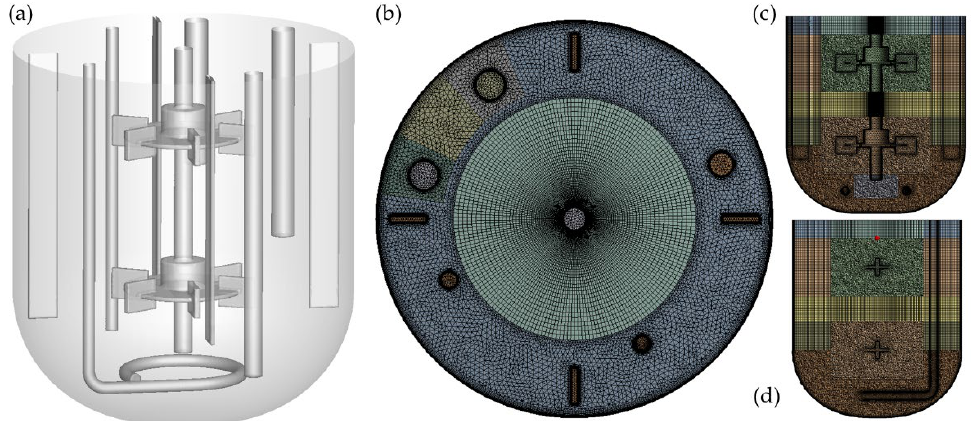
Figure 2. Computational model of the tank. ( a ) Computational domain used to model the abiotic systems. Mesh of the computational domain: ( b ) upper view, ( c ) view at middle plane across the baffles, and ( d ) view at plane across the sparger pipe. Figure adapted from Sadino-Riquelme et al. [23]. The CFD models were adapted in Ansys Fluent (versions 18.2 and 2019R3).